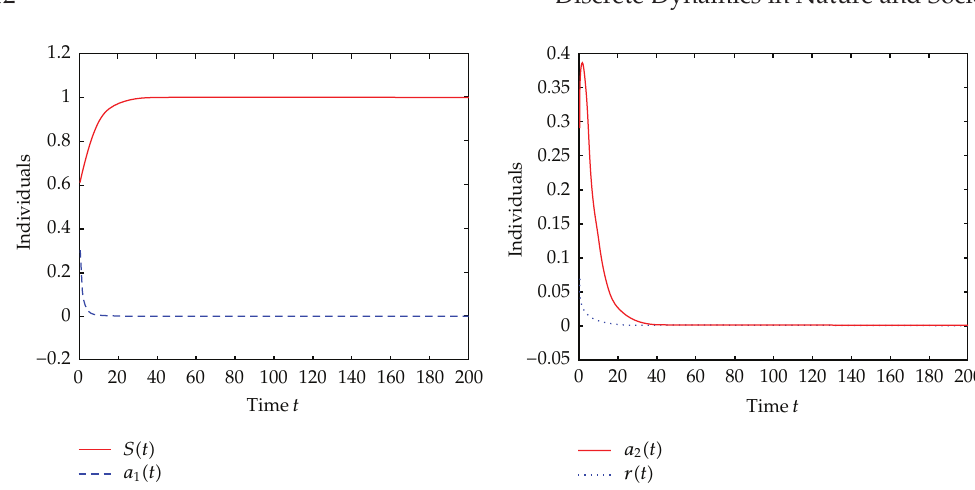
Figure 2: When p (cid:6) 0 . 8, α (cid:6) 0 . 2, and R 0 (cid:6) 0 . 4091 < 1, the alcohol-free equilibrium E 0 is globally asym- ptotically stable.